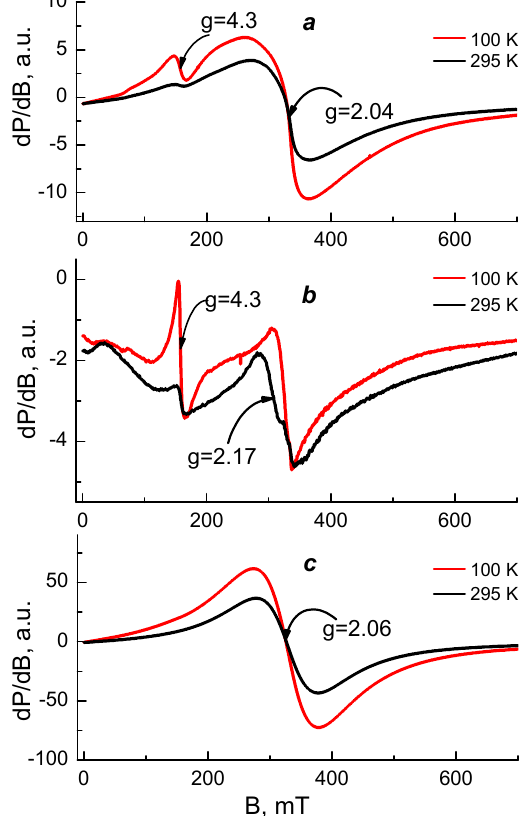
Figure 8. EPR spectra at 100 and 295 K of ( a ) Fe 3+ -Ch-8Q/PLA mat, ( b ) Fe 3+ -Ch/PLA mat and ( c ) Fe 3+ -8QCHO in the solid state.